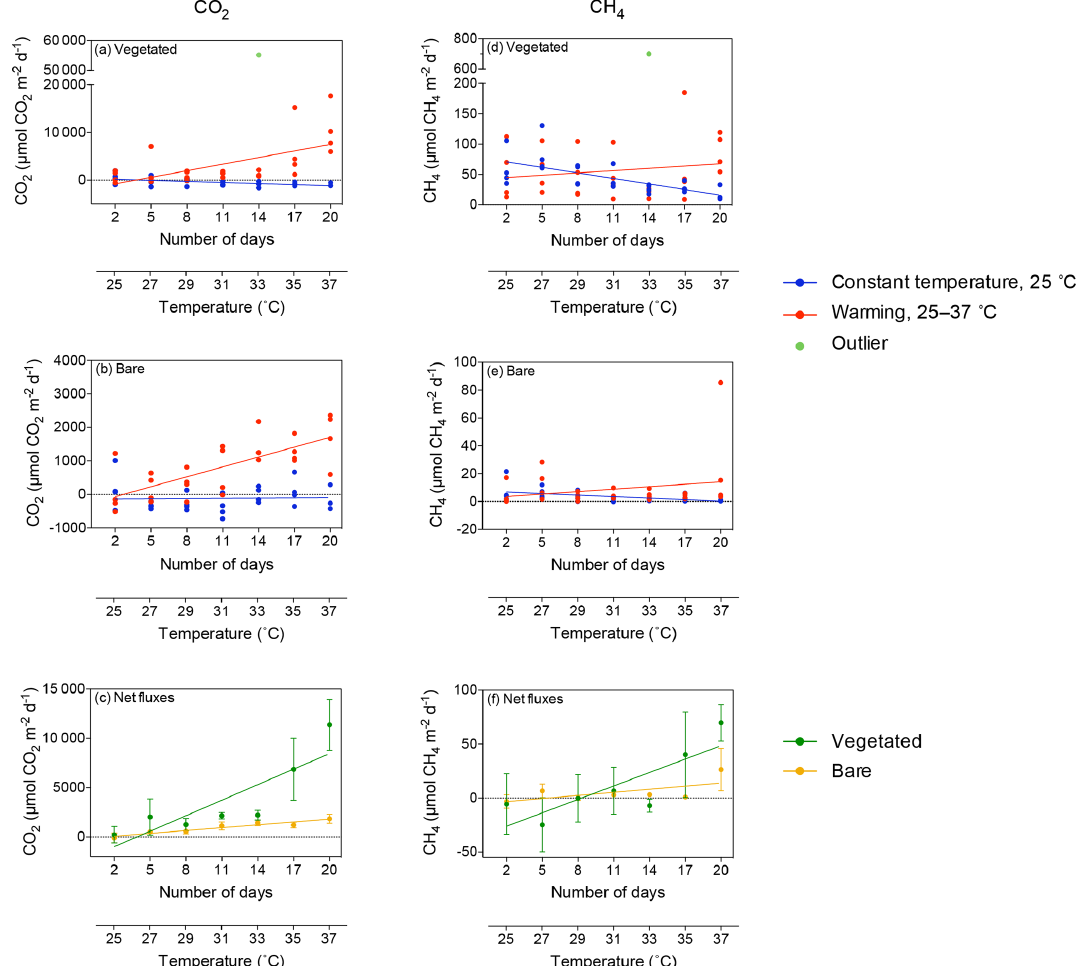
Figure 2. Mean ± SE CO 2 (left) and CH 4 (right) fluxes in (a, d) vegetated and (b, e) bare sediments. Symbols indicate each replicate of the community experiencing warming from 25 to 37 ◦ C (red) and the community maintained at 25 ◦ C (blue) over the experimental period (number of days since the onset of the experiment). An outlier at 33 ◦ C in vegetated sediments in shown in green. (c, f) Mean ± SE (c) CO 2 and (f) CH 4 net fluxes in vegetated (green) and bare (yellow) sediments over the experimental period (number of days since the onset of the experiment). The second x axis indicates the experimental temperature for the community exposed to warming from 25 to 37 ◦ C. Lines represent a fitted linear equation.